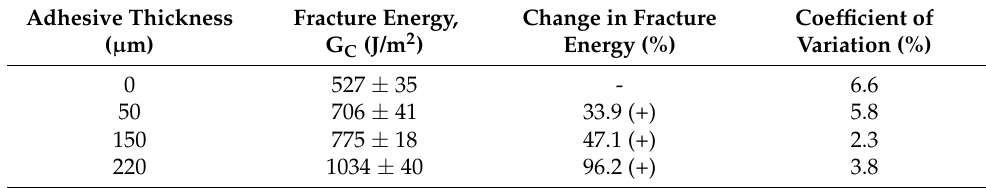
Figure 22. Mixed Mode I/II fracture energy variation with thin film thickness.